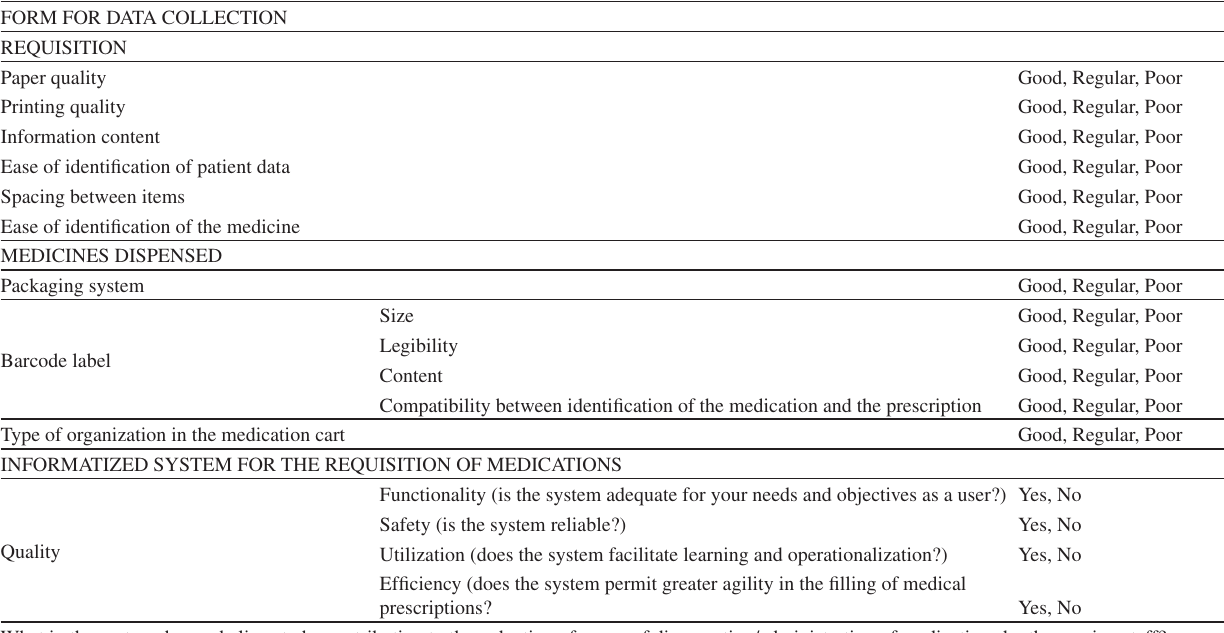
Table 1 - Items on the form for data collection regarding the informatized system for dispensing of medication from the Pharmacy Division,